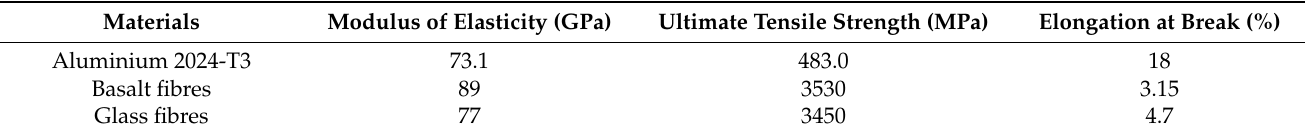
Table 1. Summary of the mechanical properties of raw materials.